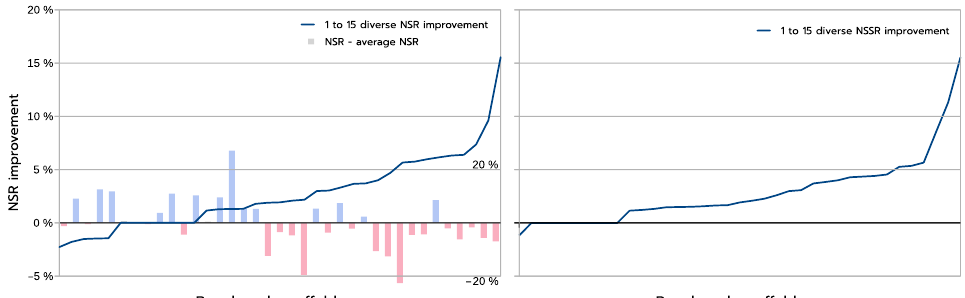
Figure 8. The blue curves above give the absolute change in NSR (Y-axis, left figure) and NSSR (Y-axis, right figure) between the best 15-diverse and the best 1-diverse sequences found for each backbone. Backbones (on the X-axis) are ordered in increasing order of the corresponding measure. In the left figure, the bar-plot shows the difference between each backbone 1-diverse NSR and average 1-diverse NSR over all backbones. The corresponding NSR change scale appears on the right with ± 20% labels. Red bars indicate a below-average 1-diverse NSR while blue bars indicate an above average 1-diverse NSR. The most improved NSRs, on the right of the left figure, mostly appear on weak (red, below average) 1-diverse NSRs.